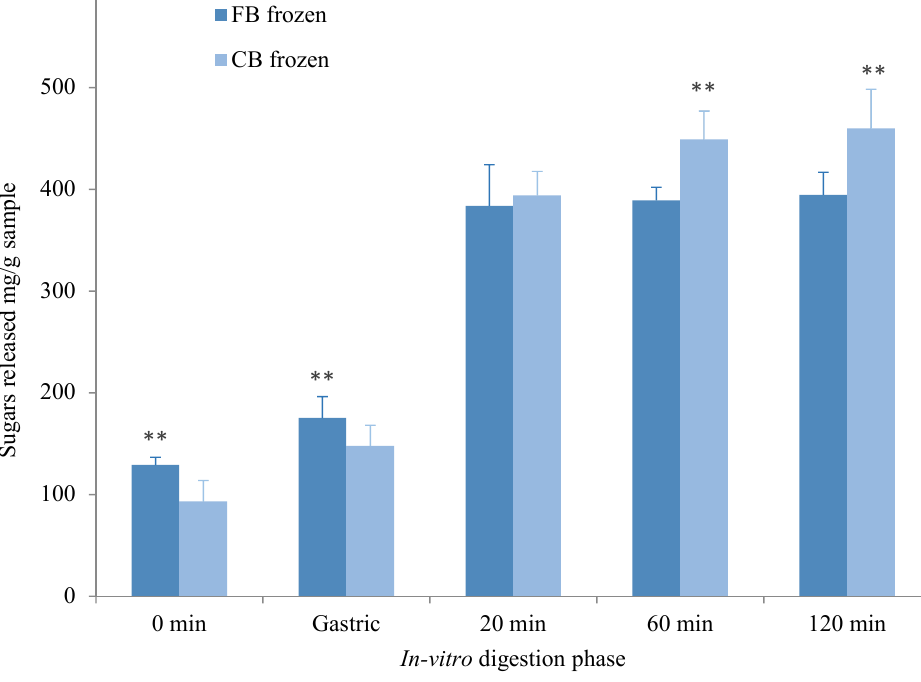
Figure 2. Sugars released between the control breakfast (CB) frozen and the functional breakfast (FB) frozen following in vitro digestion comparison. ** p < 0.05.